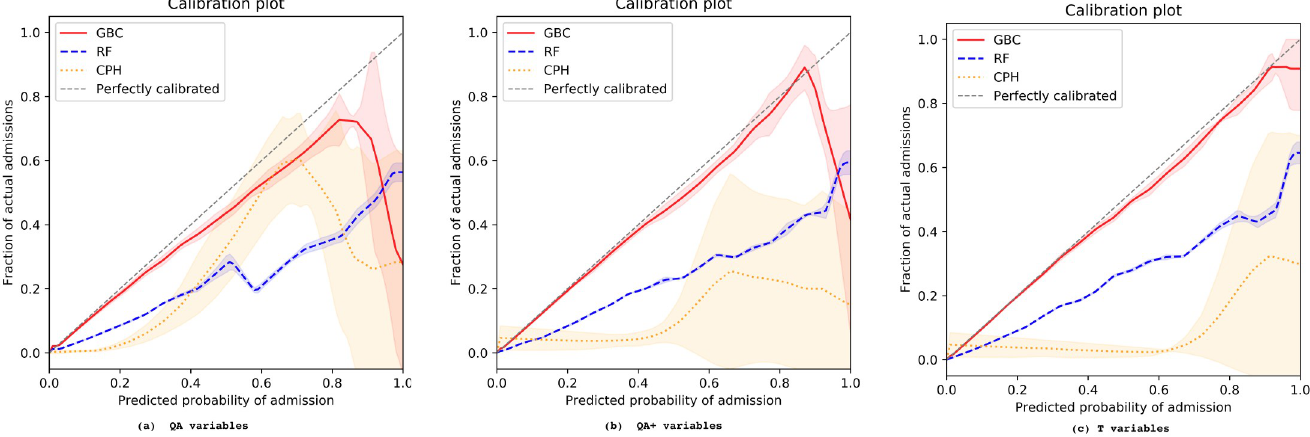
Fig 1. Cross-validated model calibration for different predictor sets and modelling techniques. (a) QA variables; (b) QA+ variables; (c) T variables. The x -axis shows the predicted probability of emergency admission, while the y -axis shows the fraction of actual admissions for each predicted probability. The shaded areas depict the standard deviation across different folds in a 5-fold cross-validation. CPH, Cox proportional hazards; GBC, gradient boosting classifier; RF, random